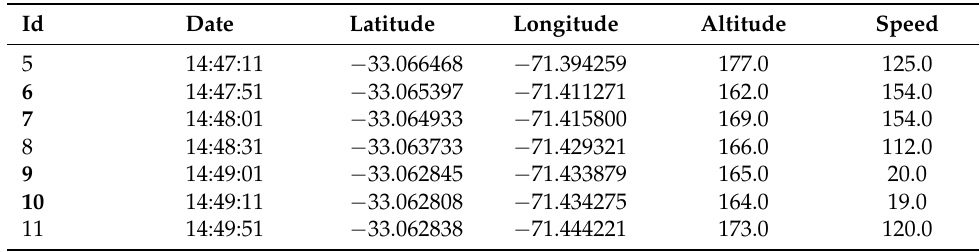
Table 12. Detail of GPS measurements with the greatest error, including contiguous ones, of the trajectory of Figure 9. The measurements that contribute the most to the trajectory error are indicated in boldface in